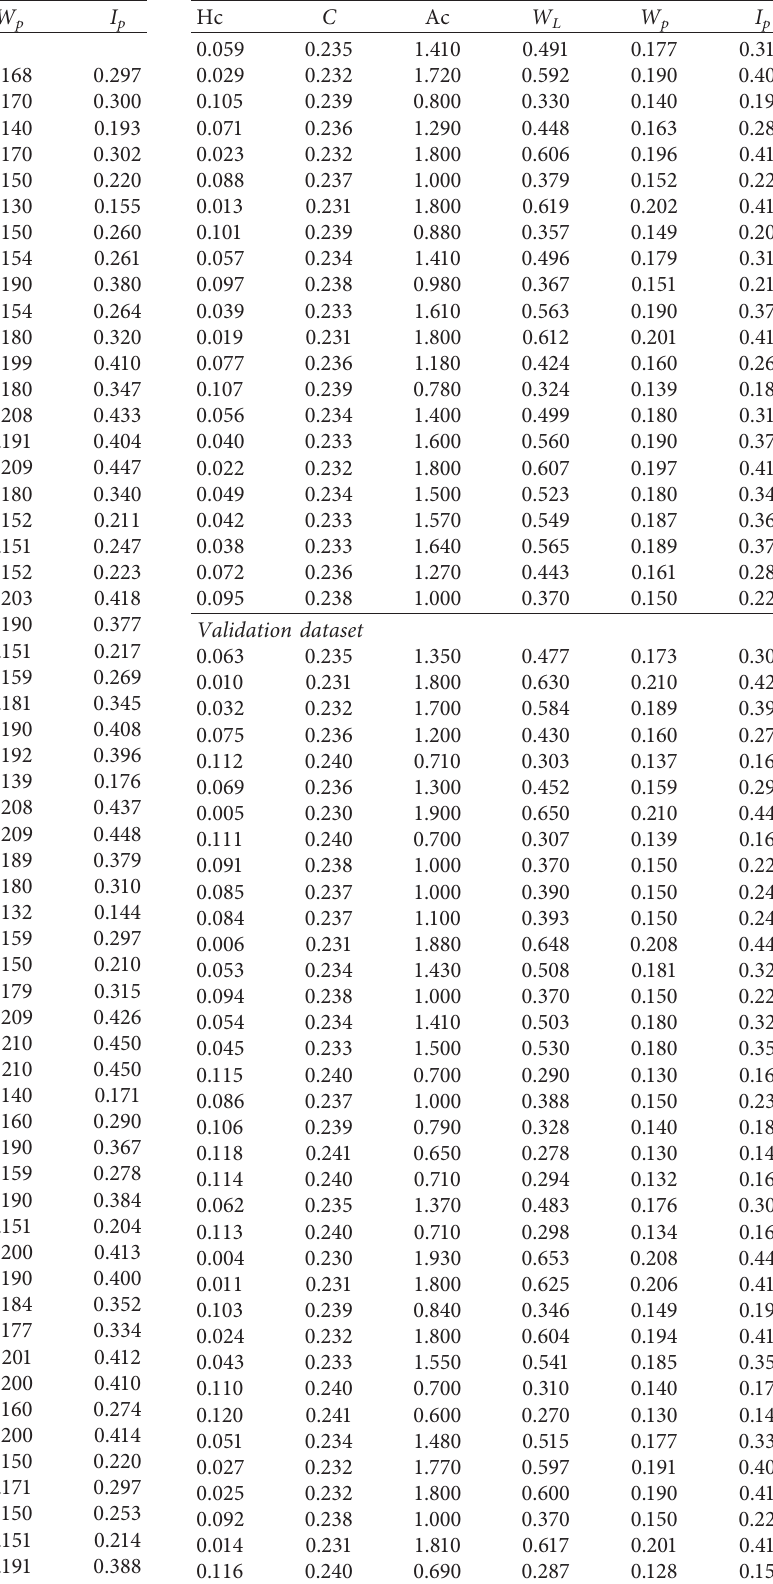
Table 1: The used